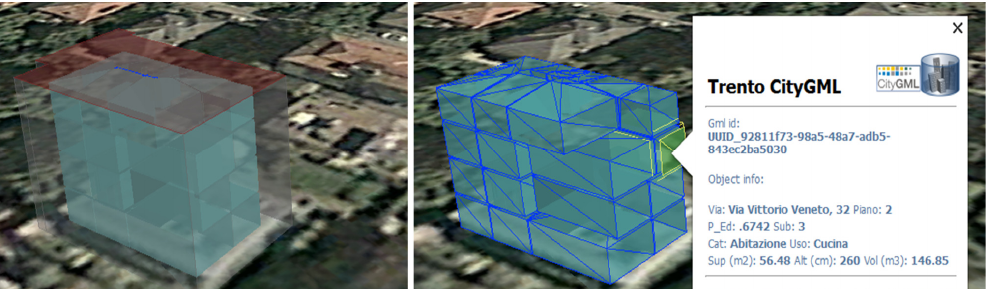
Figure 6 Automatic reconstruction of the interior rooms of a building, and successive integration in CityGML as LoD4 geometries. Visualisation in Google Earth of the exported dataset with the accompanying